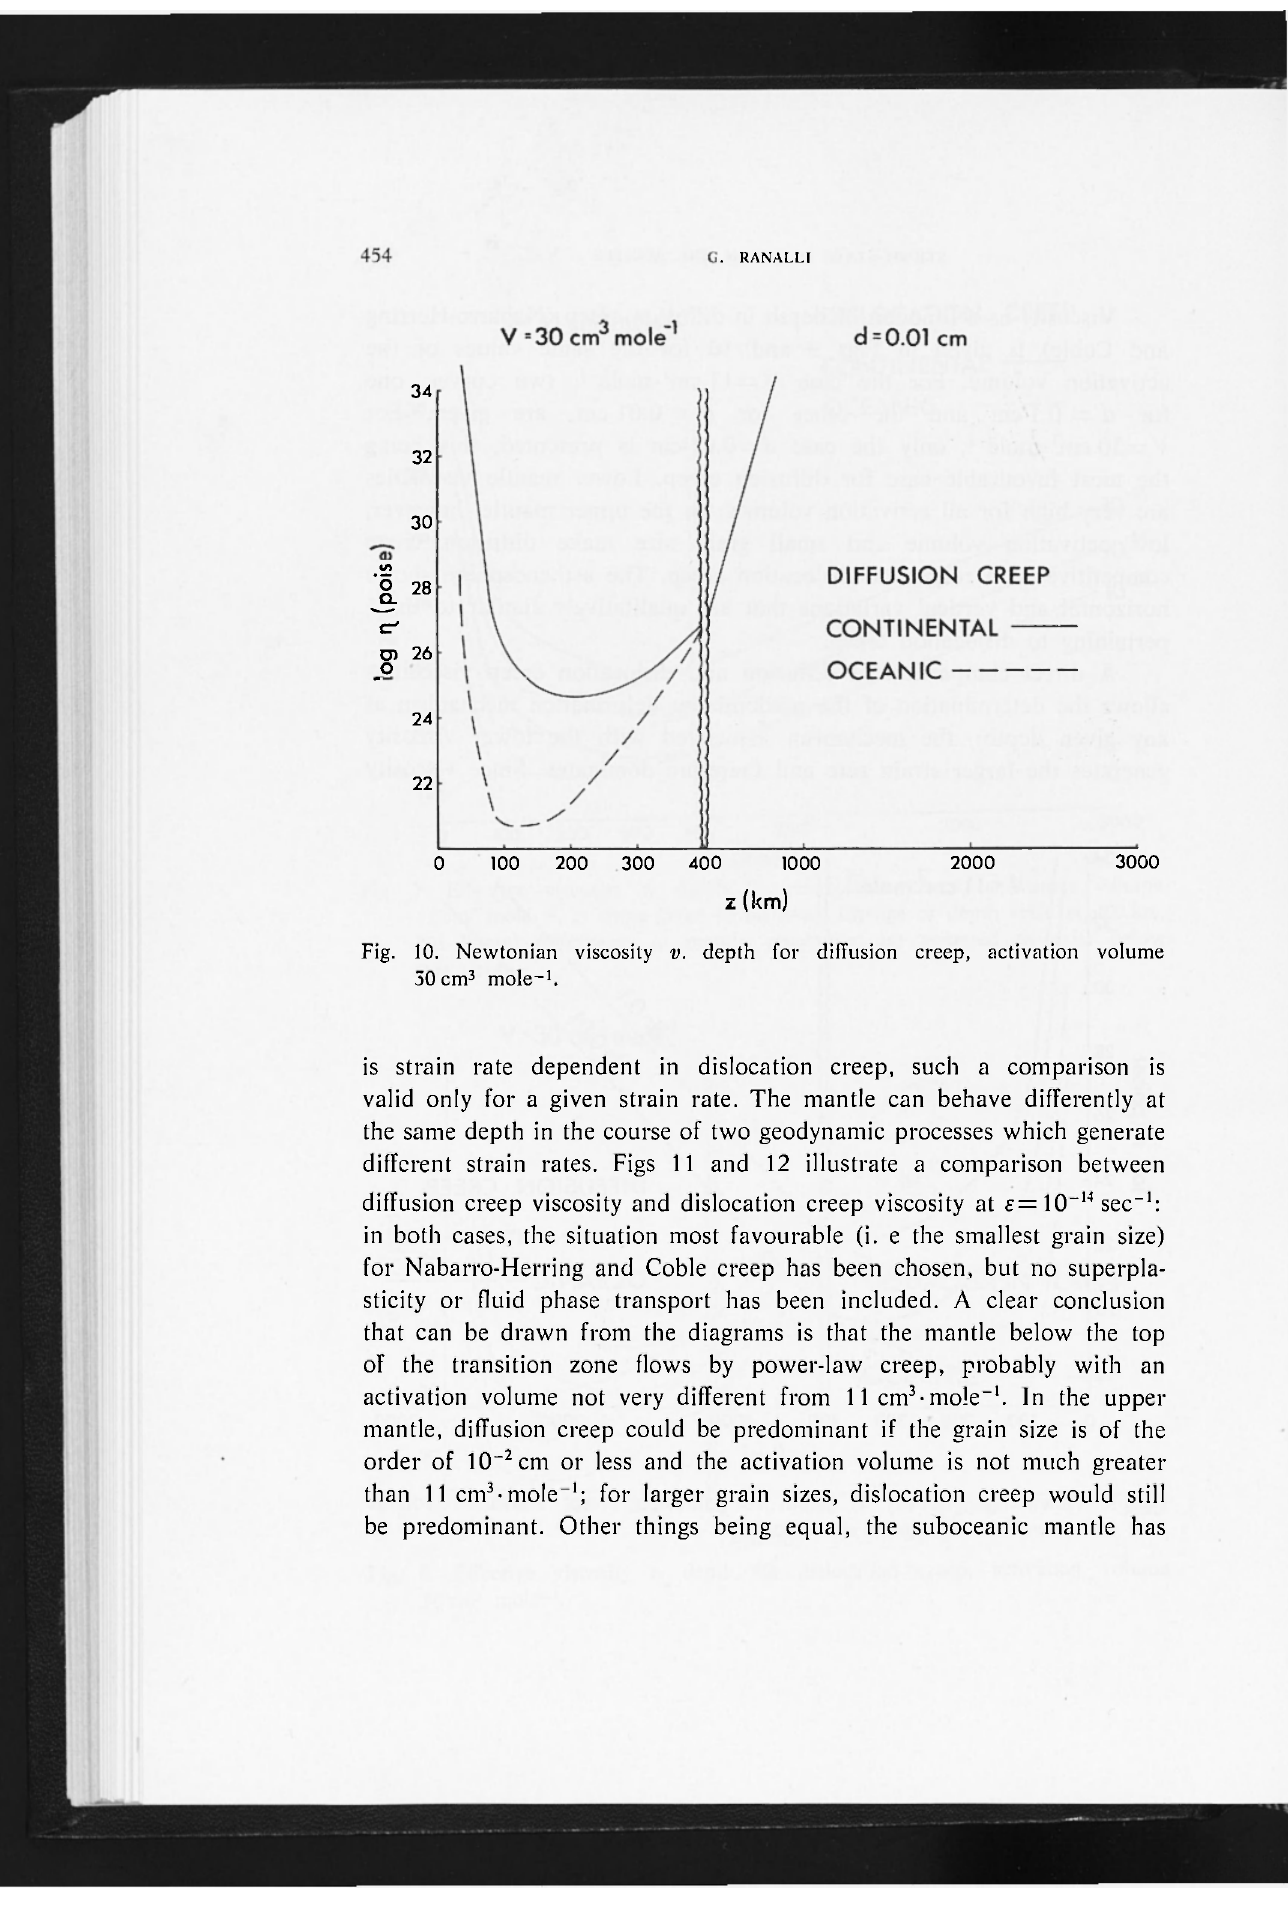
Fig. 10. Newtonian viscosity v. depth for diffusion creep, activation volume 50 cm 3 mole- 1